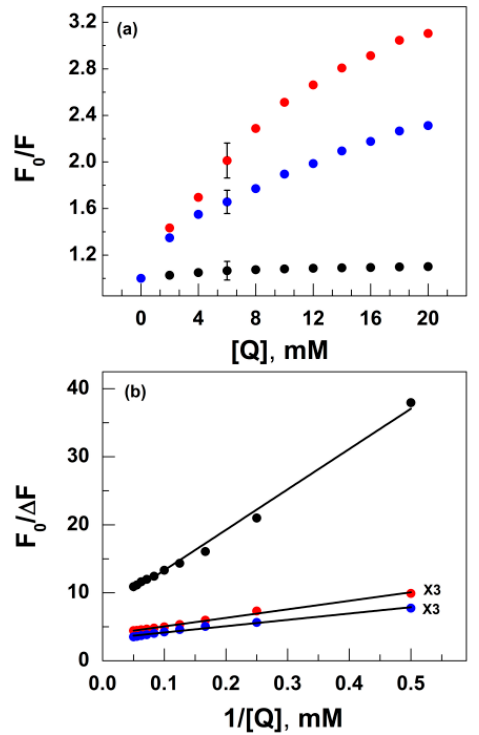
Figure 5. The Stern ‐ Volmer ( a ) and modified Stern ‐ Volmer ( b ) plots for the quenching of Figure 5. The Stern-Volmer ( a ) and modified Stern-Volmer ( b ) plots for the quenching of fluorescence fluorescence intensity of bis ‐ Ru ‐ bpp bound to polynucleotides by [Fe(CN) 6 ] 4 − . The conditions used to intensity of bis -Ru-bpp bound to polynucleotides by [Fe(CN) 6 ] 4 ´ . The conditions used to measure measure emission intensity are identical to those in Figure 4. [DNA] = 10 μ M, [Fe(CN) 6 ] 4 − = 2–20 mM emission intensity are identical to those in Figure 4. [DNA] = 10 µ M, [Fe(CN) 6 ] 4 ´ = 2–20 mM with an increment of 2 mM. Red, black, and blue circles denote poly[d(A ‐ T) 2 ], poly[d(G ‐ C) 2 ], and with an increment of 2 mM. Red, black, and blue circles denote poly[d(A-T) 2 ], poly[d(G-C) 2 ], and poly[d(I ‐ C) 2 ], respectively. poly[d(I-C) 2 ],